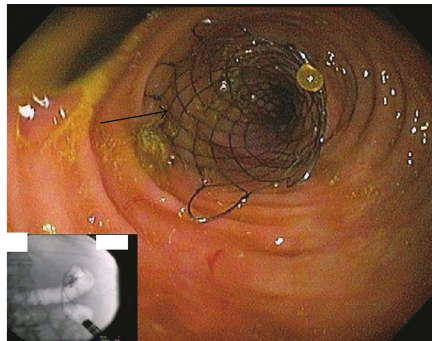
Figure 3: Colonoscopic view after colonic stent placement (arrow pointing at the stent, the inset shows the fluoroscopic